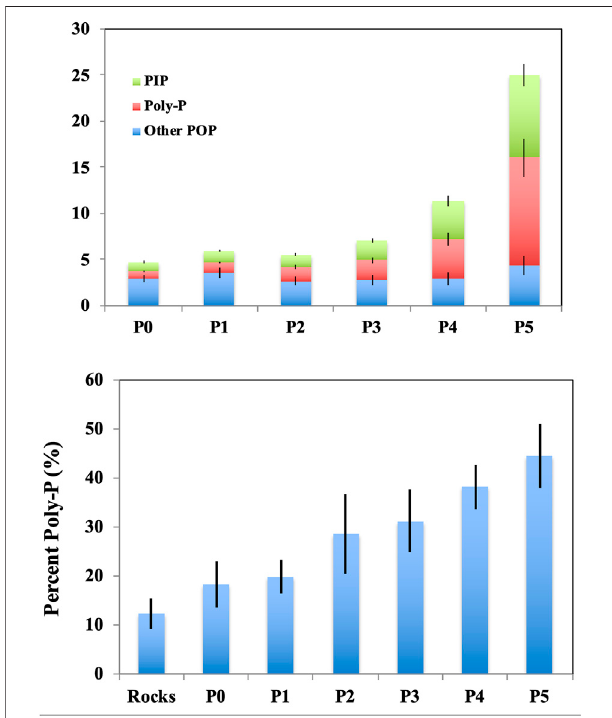
FIGURE 3 | Stacked bar chart for the mass balance of bio fi lm P among the ISES treatments (Top panel), where sites and treatment replicates were averaged (Top panel). Bar chart depicted of the percent polyP out of TP (Bottom panel). Error bars were calculated as standard